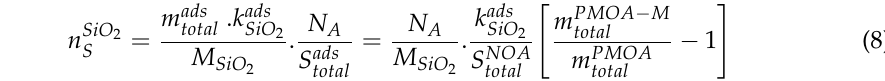
Figure 8. 200 kV HRTEM (TOPCON 002B) image of a PMOA-M sample annealed at 1400 °C. A layer of amorphous SiO 2 of 5.8 nm thickness or 17 ± 2 ML covers the surface of the crystalline Al 2 O 3 fibril. The number of SiO 2 molecules deposited per unit surface PMOA may be estimated as: